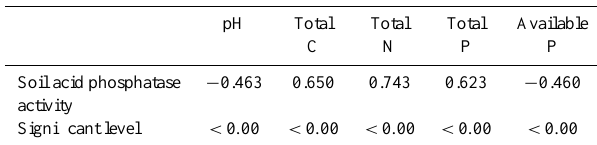
Table 3. Pearson correlation coefficients between soil acid phos- phatase activity and soil chemical properties at Dinghushan Bio- sphere Reserve.